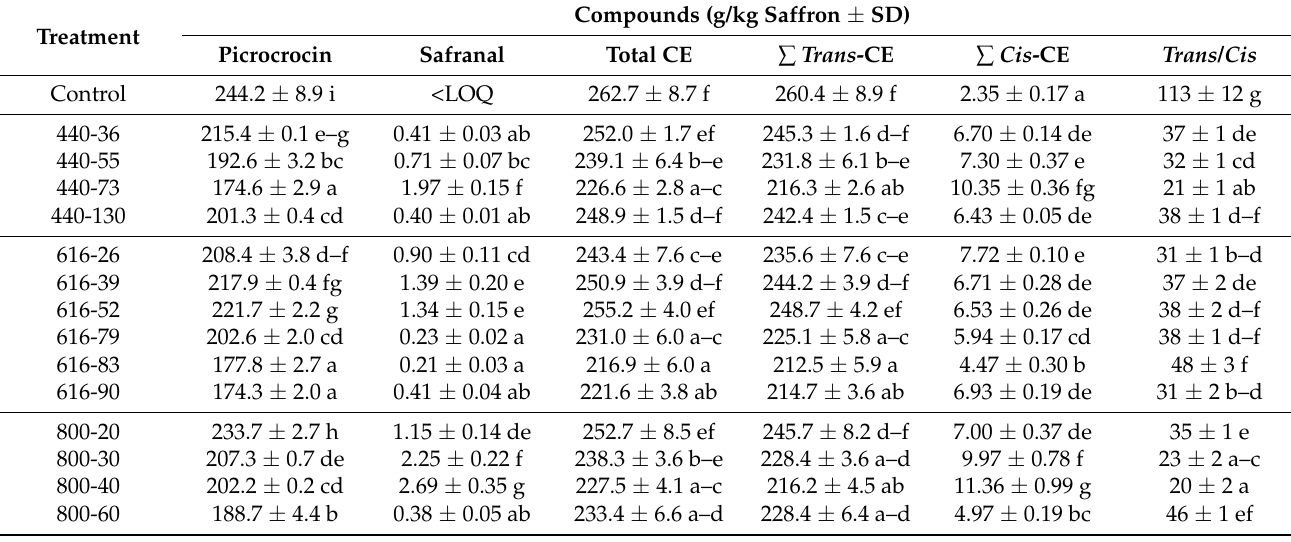
LOQ = limit of quantification. Total CE = Total crocetin esters. ∑ trans -CE = sum of trans isomers of crocetin esters. ∑ cis -CE = sum of cis isomers of crocetin esters. Values are the mean of two extracts conducted in duplicate (2 × 2 n), SD = standard deviation. One-way analysis of variance (ANOVA) for each column is included. Different letters within each column represent statistically significant variances, according to Duncan test ( p <